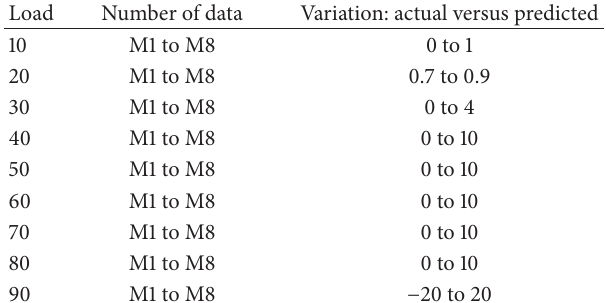
Figure 10: Prediction of flexural strength. Table 6: Variation on actual and predicted values of deflection in flexural strength